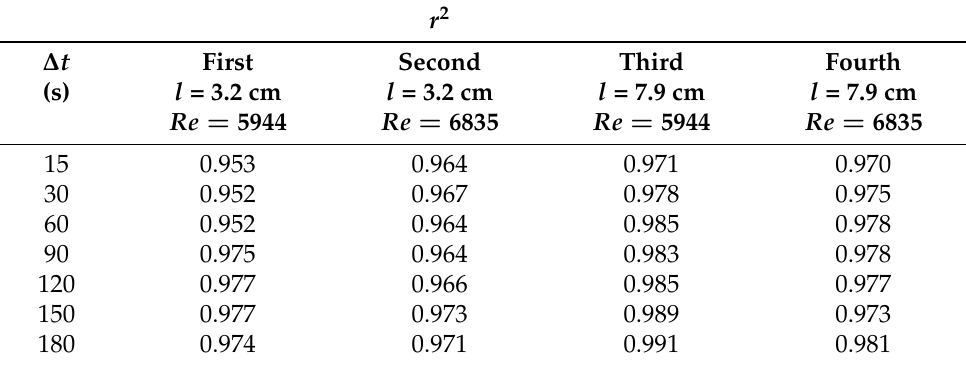
Table 4. Values of r 2 related to previous fitting laws for each configuration at several aggregation time ranges.